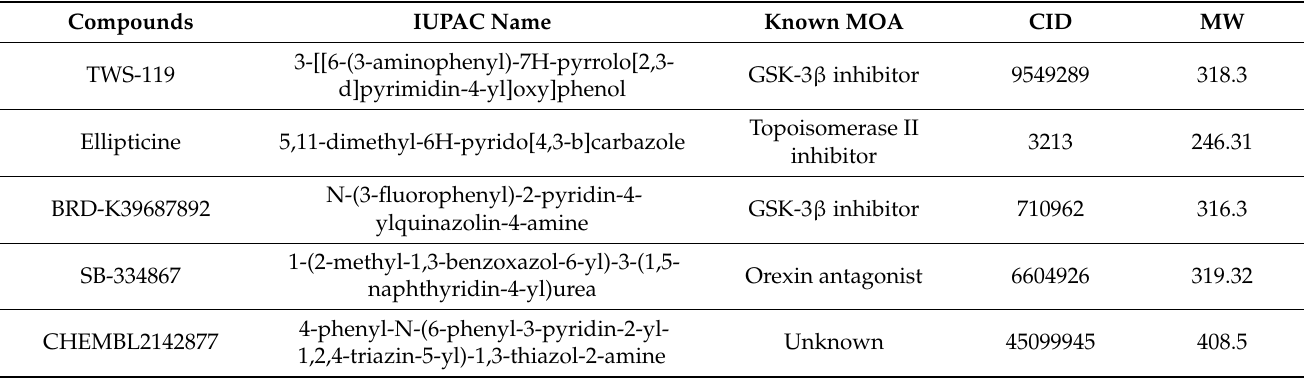
Table 2. List of chemicals of